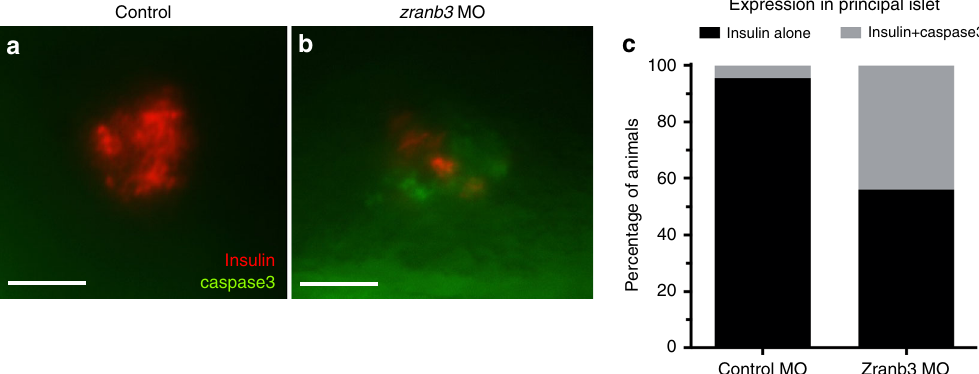
Fig. 5 Increased islet apoptosis with loss of zranb3 . a , b Co-localization in larval islets of activated Caspase-3 with insulin by whole-mount double immunostaining demonstrating signi fi cantly higher proportion of embryos exhibiting co-localization in larval (5 dpf) islets compared to controls, as quanti fi ed in ( c ). Data indicate average of three replicate experiments. Each experiment is n = 8 – 10